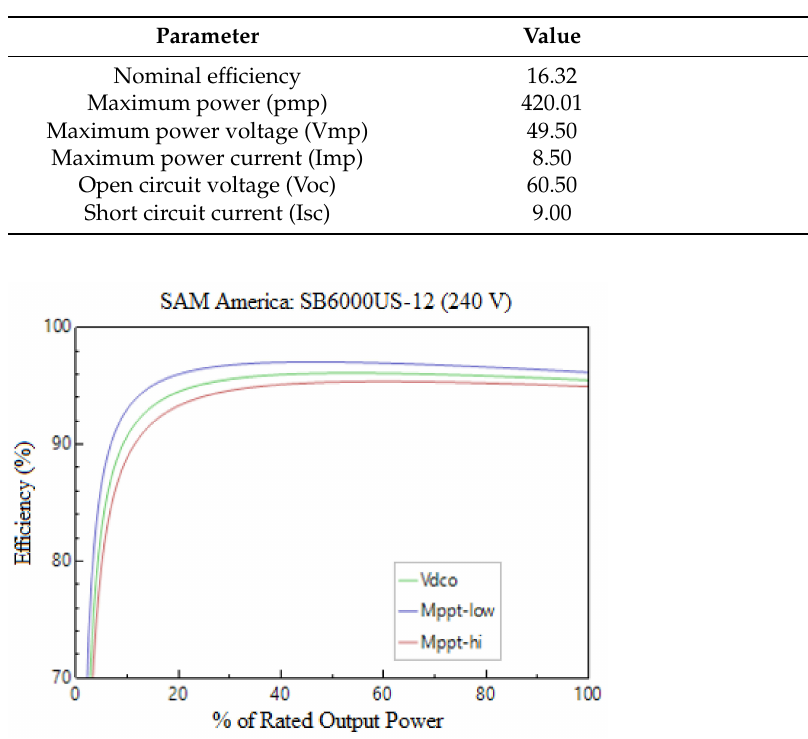
Figure 8. Module’s I–V curve. Courtesy of NREL [37]. Table 2. Module characteristics at reference conditions. Courtesy of NREL [37].